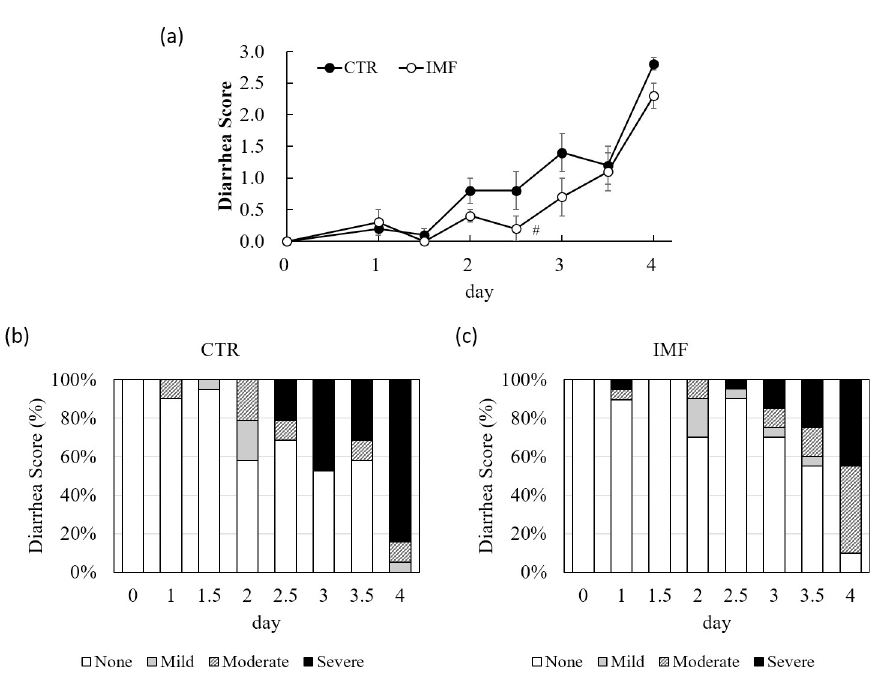
Fig 3. Average diarrhoea score and incidence of diarrhoea over time in the CTR and IMF rats. ( a ) average diarrhoea score, ( b ) incidence of diarrhoea in the CTR rats after 5-FU injection and ( c ) incidence of diarrhoea in the IMF rats after 5-FU injection. Values are means ± standard error. # P < 0.1, vs. CTR group.